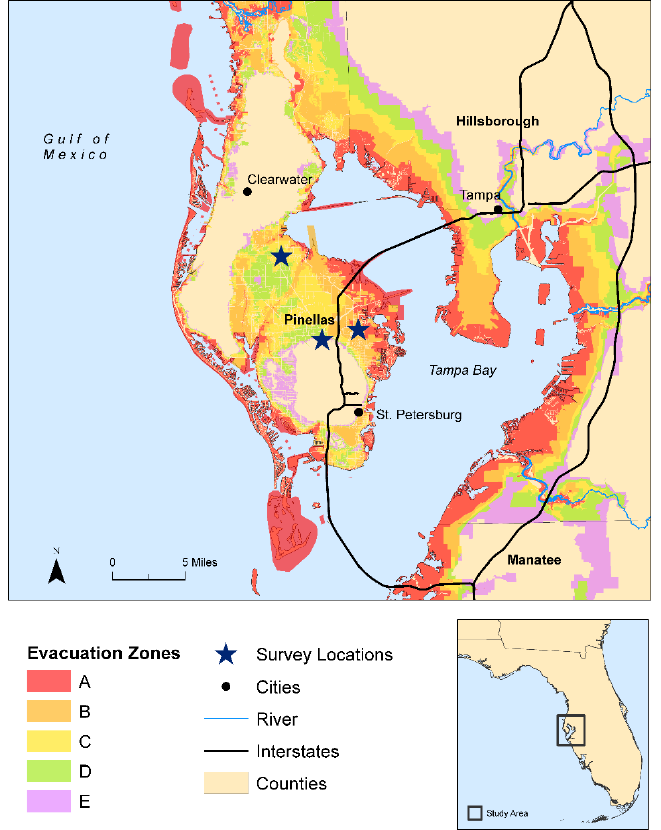
Figure 2. Survey distribution locations.